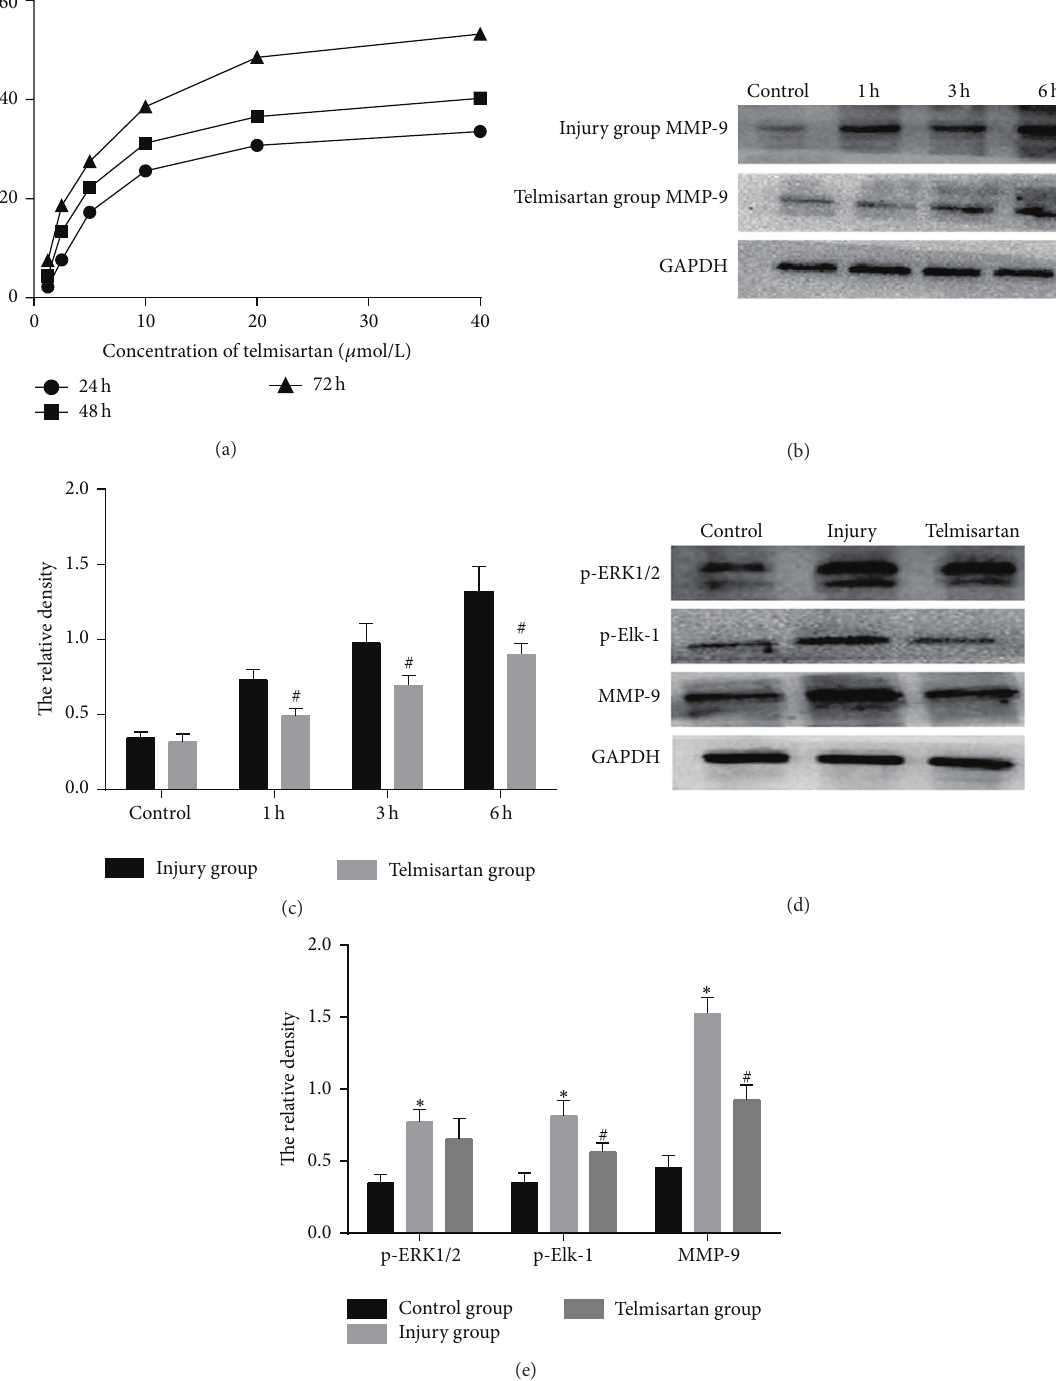
Figure 6: Telmisartan suppresses MMP-9 expression by inhibiting Elk-1 phosphorylation in THP-1 cells induced by scratch-injured human umbilical vein endothelial cells (HUVECs) supernatants. (a) Growth inhibiting effects of telmisartan on THP-1 cells. THP-1 cells were treated with 1.25, 2.5, 5, 10, 20, and 40 𝜇 mol/L of telmisartan for 24, 48, and 72 h. Cell proliferation was determined by MTT assay. (b) MMP-9 protein expression in THP-1 cells incubated with scratch-injured HUVECs supernatants for 1, 3, and 6 h. THP-1 cells in telmisartan group were pretreated with telmisartan for 1 h before HUVECs supernatants treatment. (c) Quantitative data for (b). (d) ERK1/2 and Elk-1 phosphorylation and MMP-9 protein expression in control, injury, and telmisartan groups. Control group was THP-1 cultures treated with supernatants of HUVECs without injury, while injury group and telmisartan group were cultures treated with supernatants of HUVECs with scratch injury for 6 hours. Cultures of telmisartan group were pretreated with telmisartan for 1 h prior to HUVECs supernatants treatment. (e) Quantitative data for (d). Note: ∗ 𝑃 < 0.05 compared with control group; # 𝑃 < 0.05 compared with injury